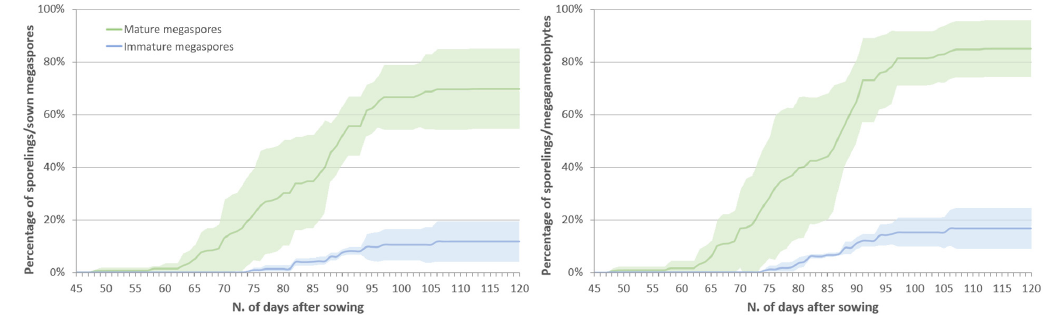
Figure 4. Time courses of the cumulative percentages of in vitro sporeling emergence from mature (green line) and immature (blue line) megaspores ( a ) and megagametophytes ( b ) of Isoëtes sabatina incubated in water-agar medium in a mixed spore culture. Data are represented as the average values with the shaded areas representing the standard deviation.